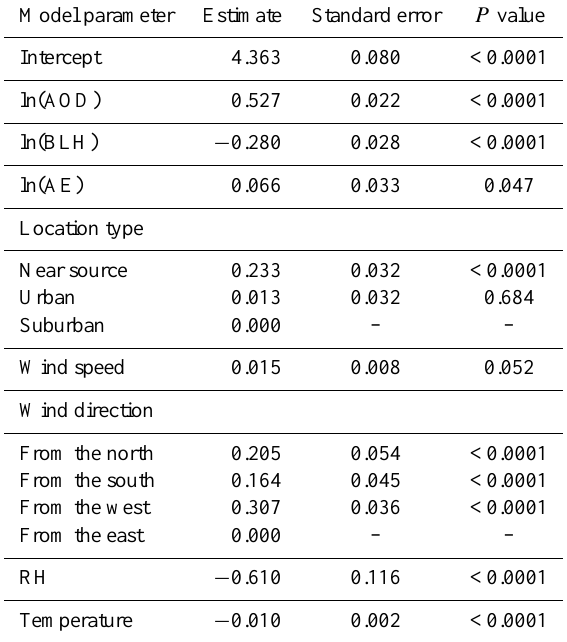
Table 4. Estimated regression coefficients for the multiple lin- ear regression model (M6) (described in Sect. 3.2, Eq. 5) using AERONET data ( N =